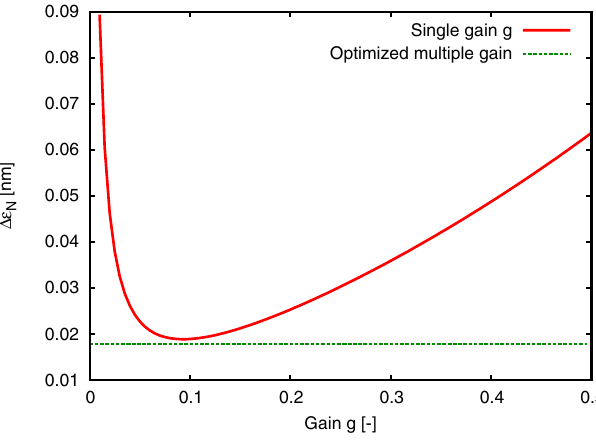
FIG. 18. (Color) Total gain-dependent emittance growth for various values of the single gain parameters and for the optimal multiple gains (see Fig. 17). For the optimal single gain g (cid:6) (cid:6) 0 : 019 nm compared 0 : 093 , the emittance growth is (cid:1) (cid:2) N